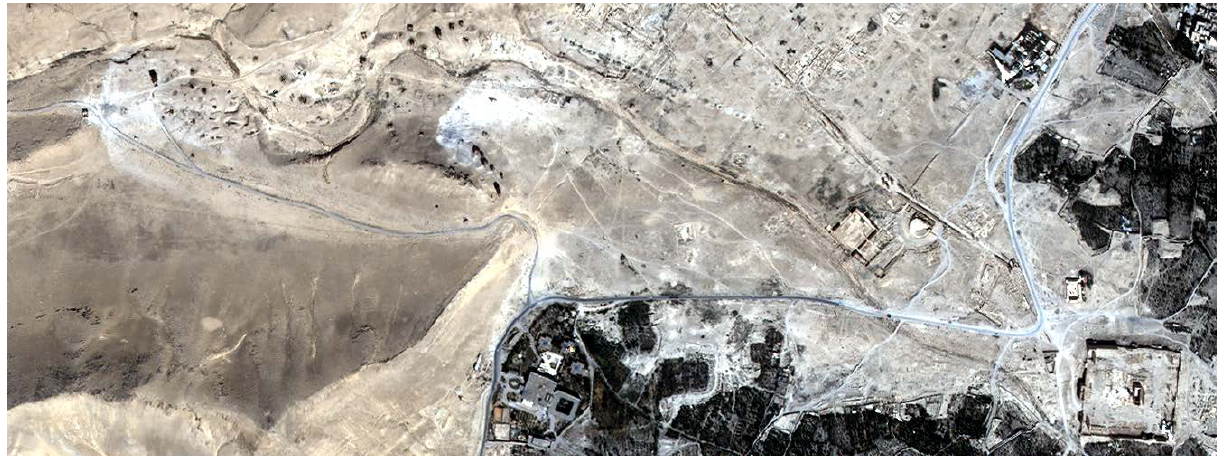
Figure 2. Subset of the WorldView-2 image acquired on the 27 th of August 2015 (©European Space Imaging / DigitalGlobe).